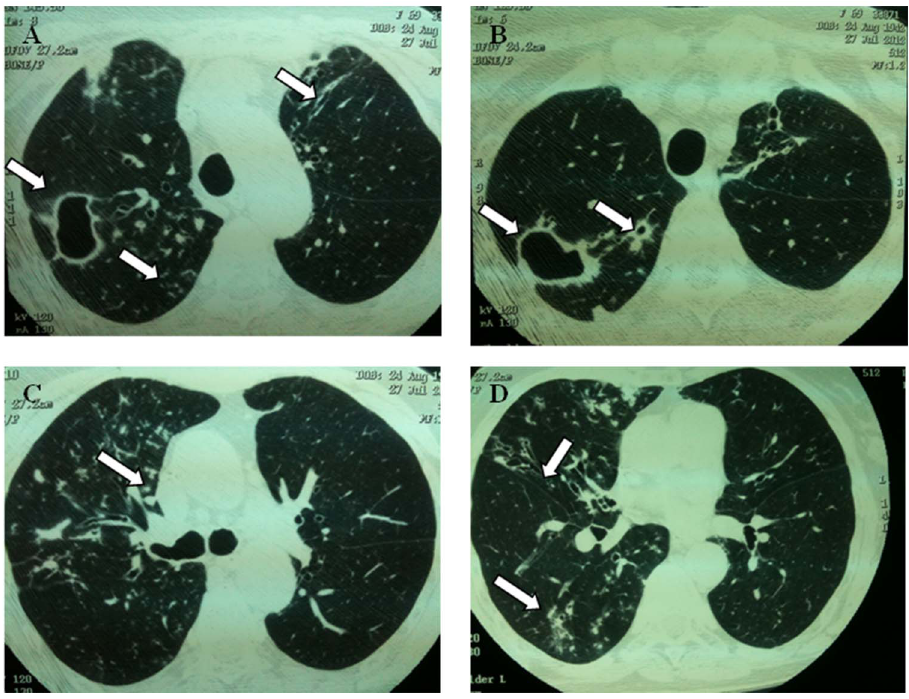
Figure 2. Representative image showing lung damage in a patient with nontuberculous mycobacterial diseases. A 69-years-old woman with Mycobacterium abscessus pulmonary disease. (A and B) High resolution computed tomography (HRCT) of the chest obtained at level of upper lobes showing multiples cavities in the right upper lobe and centrilobular nodules. It is also possible to observe bronchiectasis in left upper lobe (arrow). (C) Tree-in-bud pattern. (D) Presence of bronchiectasis in middle lobe. Also note centrilobular nodules at right lower lobe.